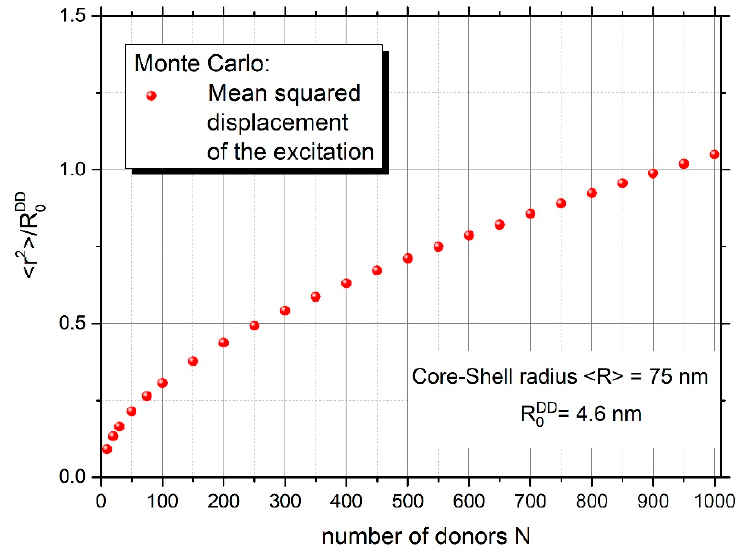
Figure 7. Relative mean squared displacement of excitation energy versus the number of donors on the nanoparticle.